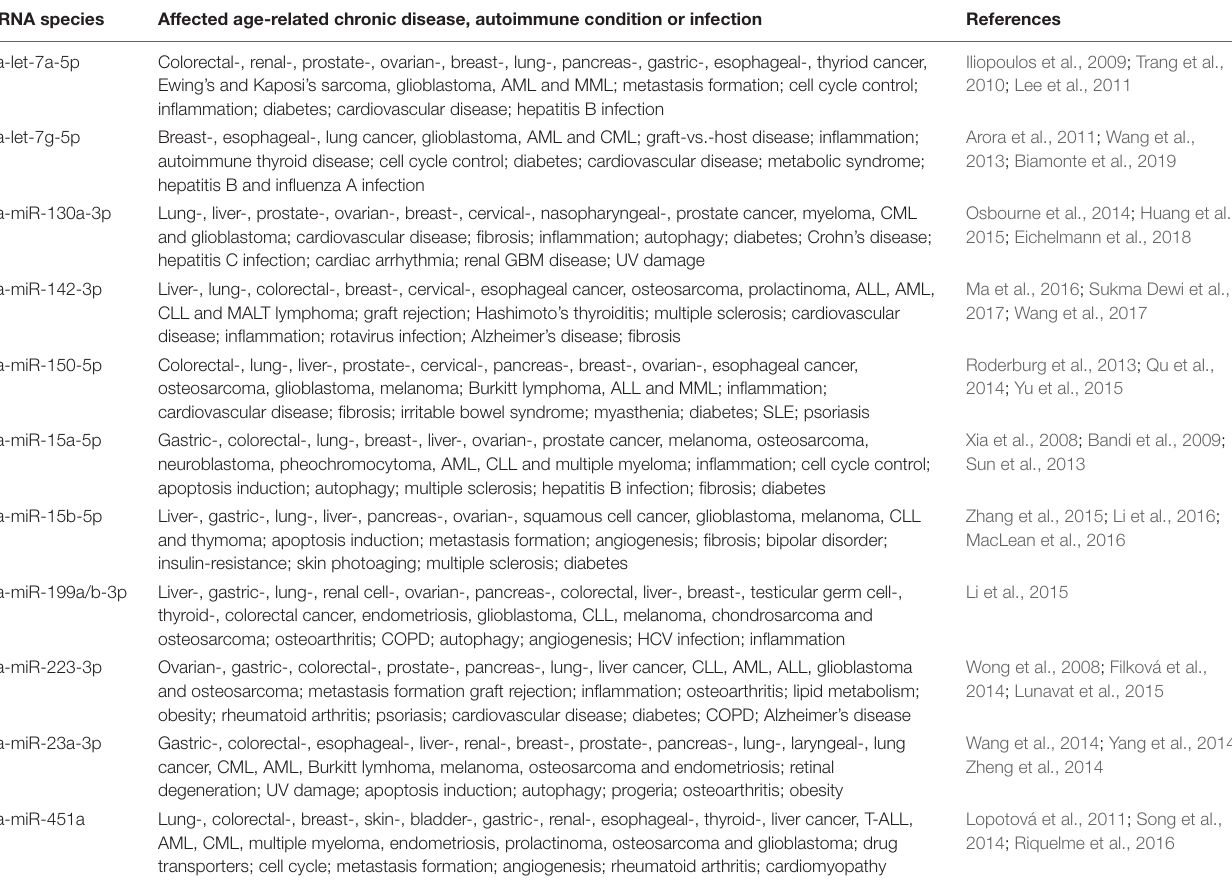
TABLE 2 | Summary of exomiR biomarkers related to certain diseases according to EVmiRNA database. miRNA